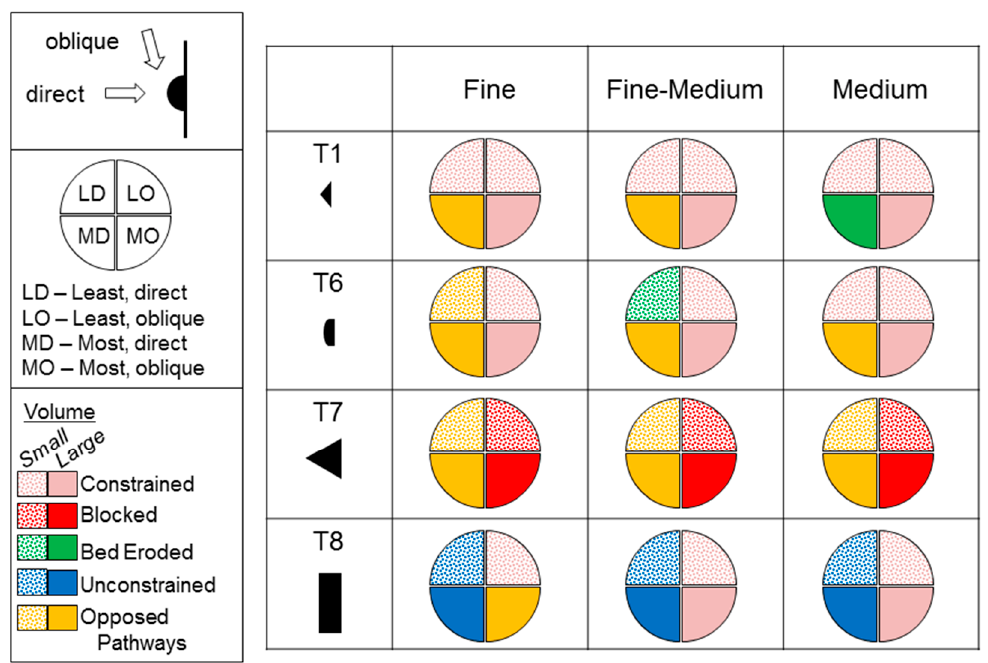
Figure 9. Summary of sediment bypassing a headland based on β headland for all grain sizes. See Equation (13) for definitions of β headland categories.